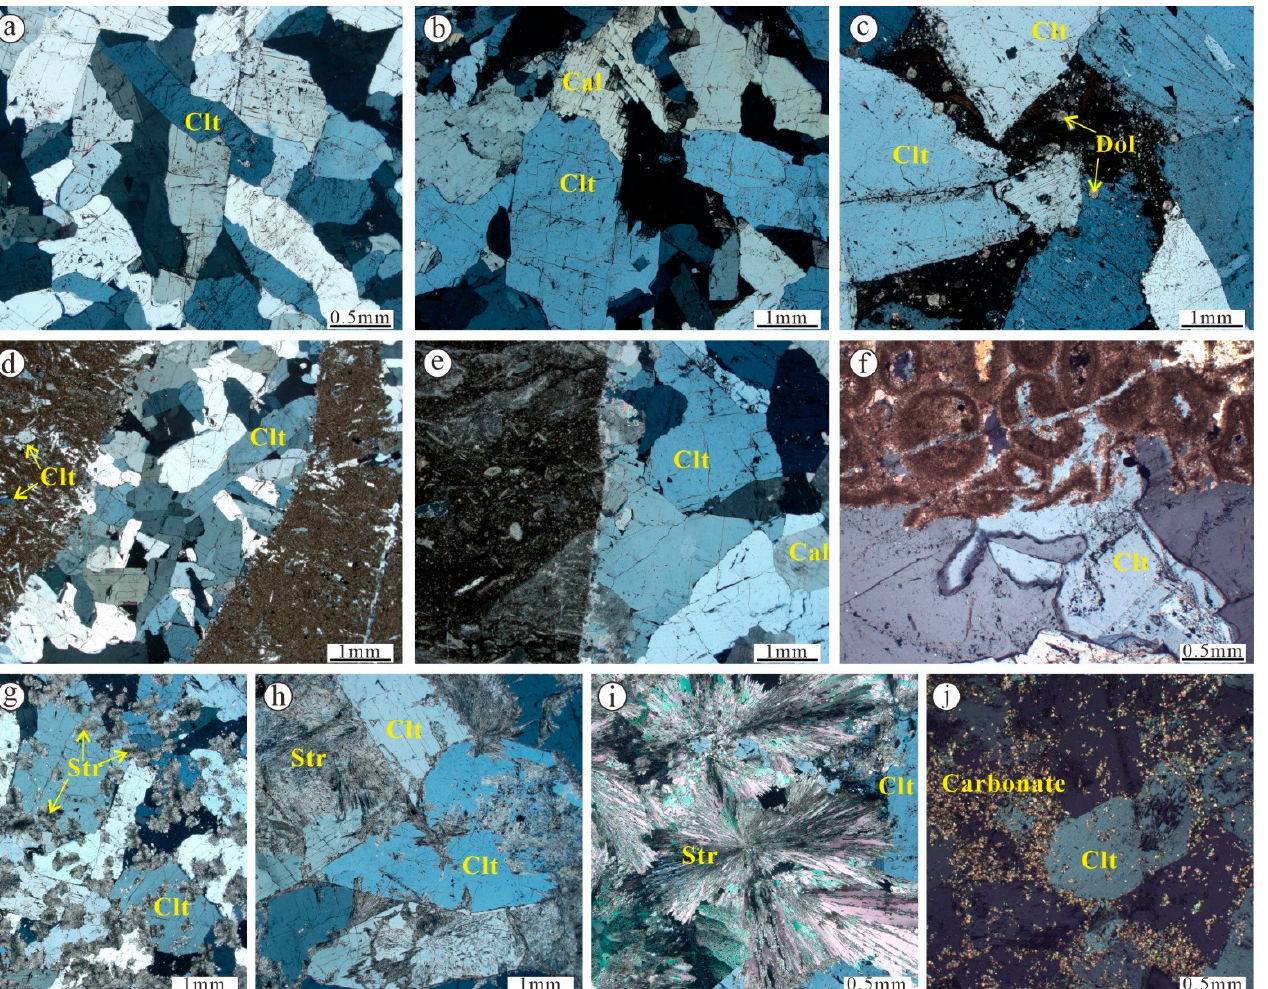
Figure 6. Photomicrographs of ore and gangue minerals in the Yuxia and Xinglong celestine deposits. ( a ) Euhedral–hypidiomorphic tabular celestine. ( b ) Celestine coexists with calcite. ( c ) Dolomite and muddy dolomite exist in the gap of the celestine. ( d ) Veined and disseminated celestine. ( e ) Veined celestine; the wall rock is bioclastic limestone. ( f ). Oolitic limestone was filled and replaced by later celestine. ( g – i ) Different degrees of strontianitzation. ( j ) Carbonatization. Clt = celestine; Cal = calcite; Dol = dolomite; Str = strontianite.